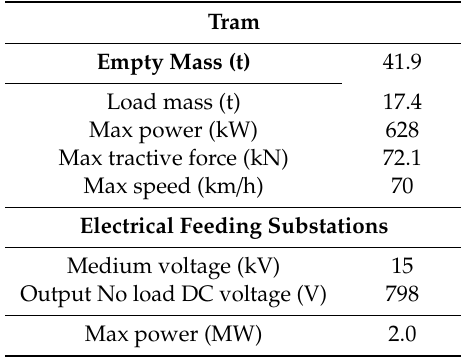
Table 1. Main features of the